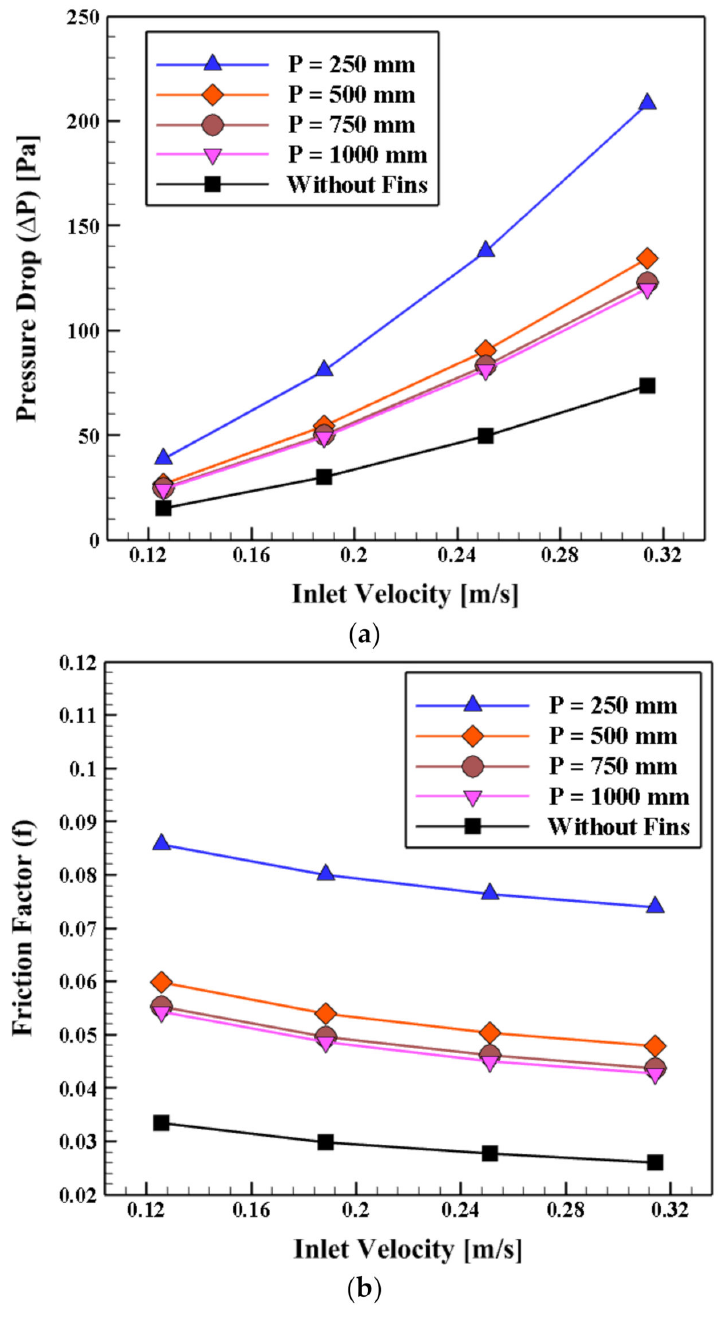
Figure 15. ( a ) Pressure drop and ( b ) friction factor (f) variation with the inlet velocity for various models at P = 500